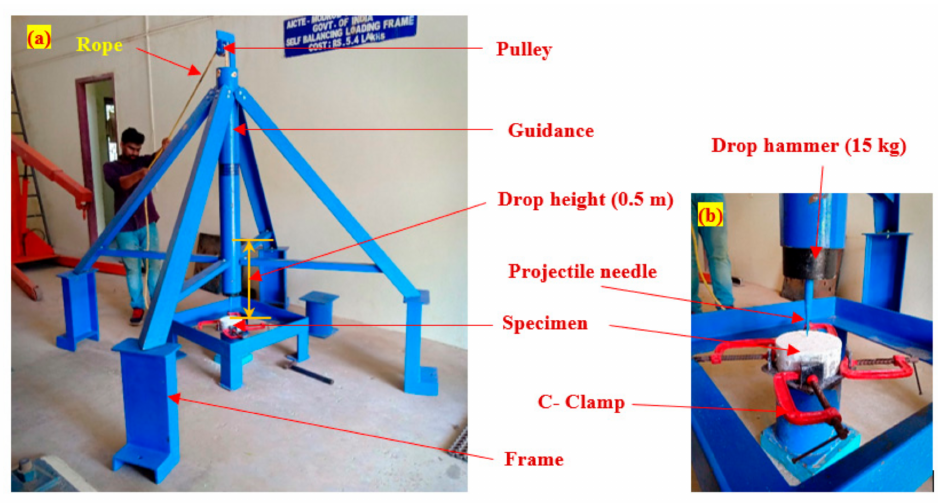
Figure 6. Low-velocity drop weight and projectile impact testing device ( a ) Test setup and ( b ) Details of accessories.